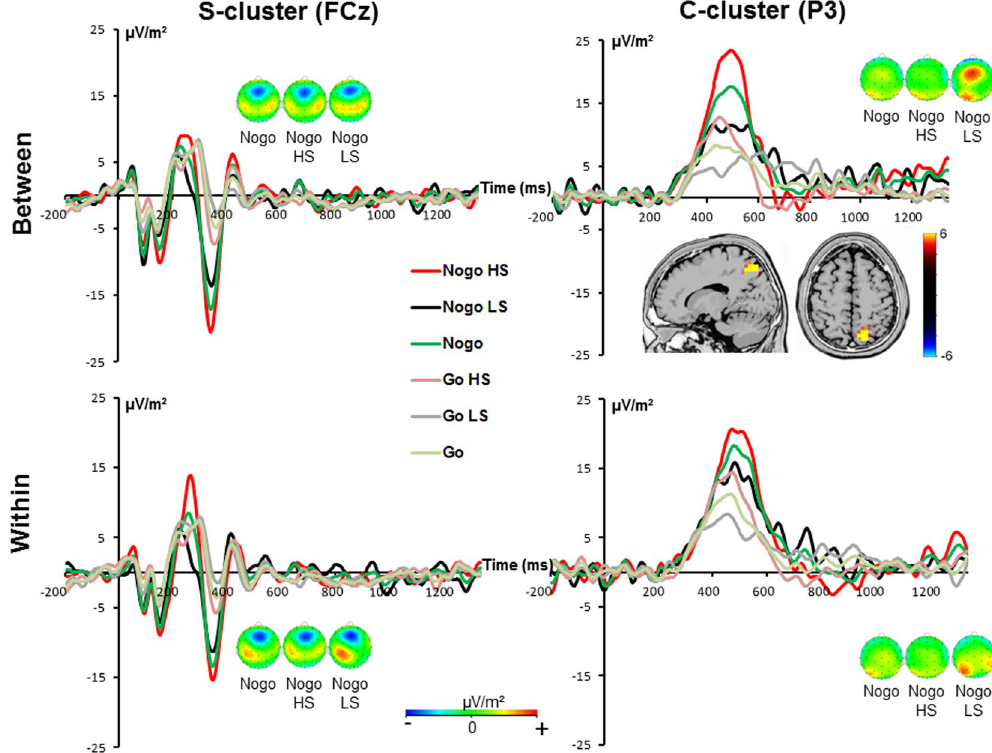
Figure 3. The S-cluster at electrode FCz (left) and the C-cluster at electrode P3 (right) is shown for the within- hand and the between-hands condition in GO and NOGO trials for the total sample (green and light green lines) as well as for the high (HS) and the low (LS) suppression group. In all plots time point 0 marks stimulus presentation. On the left the N2 component reflected in the S-cluster is shown as well as the scalp topography plots in NOGO trials. On the right the P3 component reflected in the C-cluster and the scalp topography plots in NOGO trials are illustrated. Red color represents positive values and blue color negative values. The sLORETA plot shows the source of the difference in the C-cluster modulation in NOGO trials in the high and the low suppression group. The sLORETA color scale shows the critical t-values (corrected for multiple